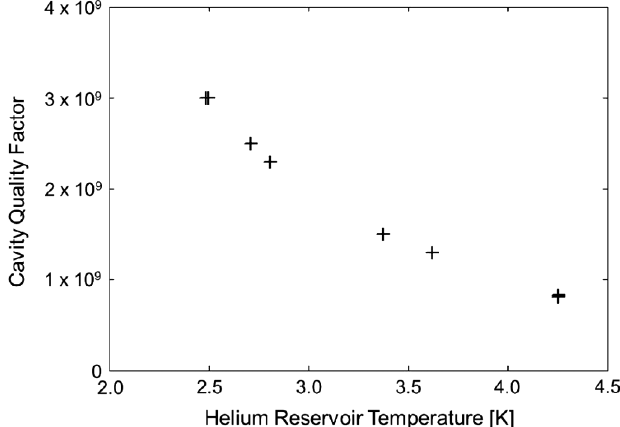
FIG. 13. Effect on cavity Q due to operation at reduced tem- perature. Temperature was determined by measuring the pres- sure of the helium vapor during vacuum pumping on the reservoir, and applying the fitting curve P ð T Þ ¼